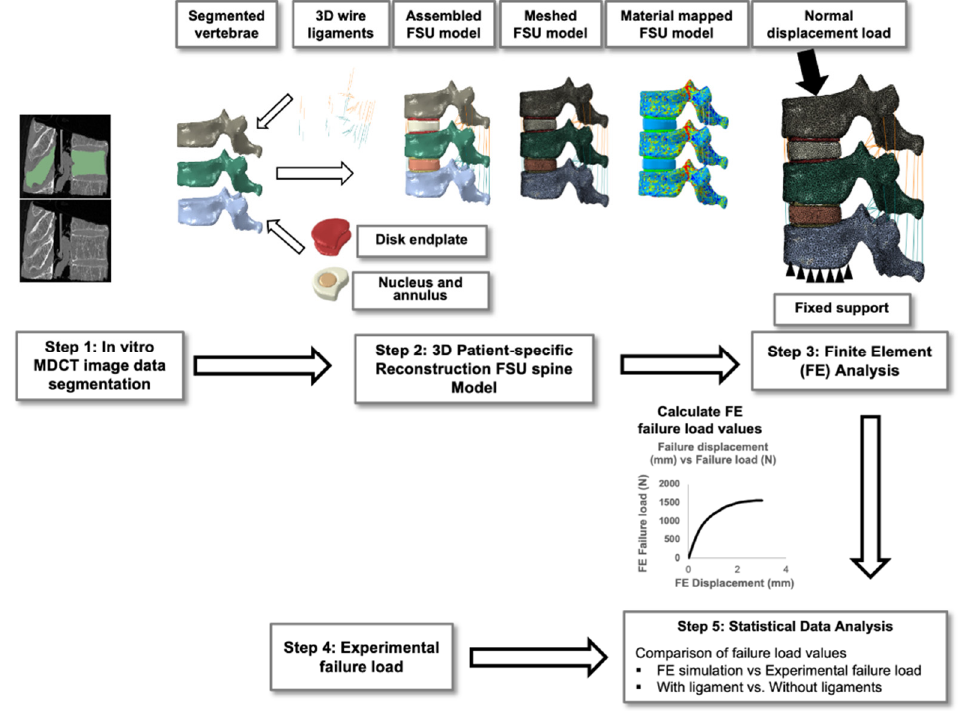
Figure 1. The five-step methodology followed in the current finite element study for the calculation of the failure load for the functional spine unit.